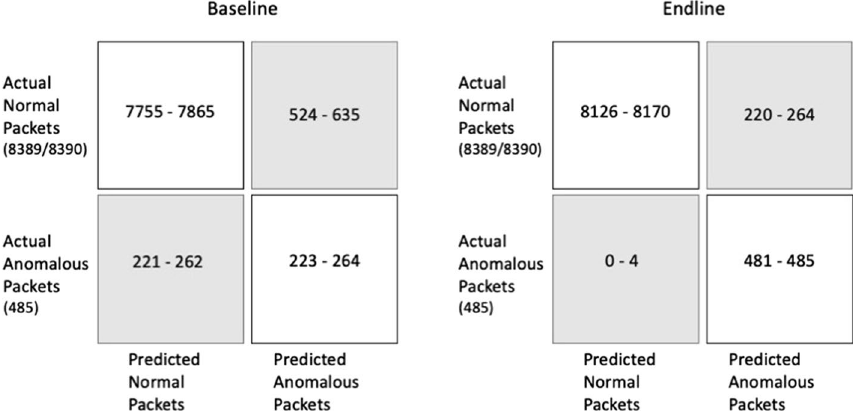
Fig. 6 Resulting confusion matrices from 10x5 cross-validations of one-class SVM for anomaly detection on IEC 104 test sets for baseline and endline